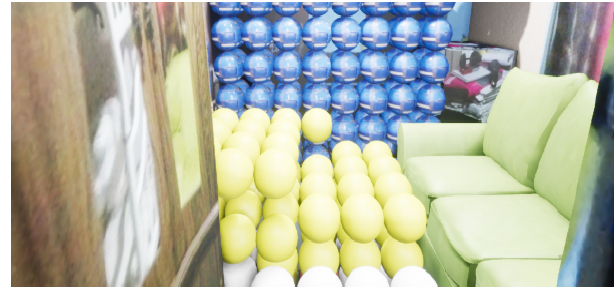
Figure 20. Representation of mesh navigations in 3D